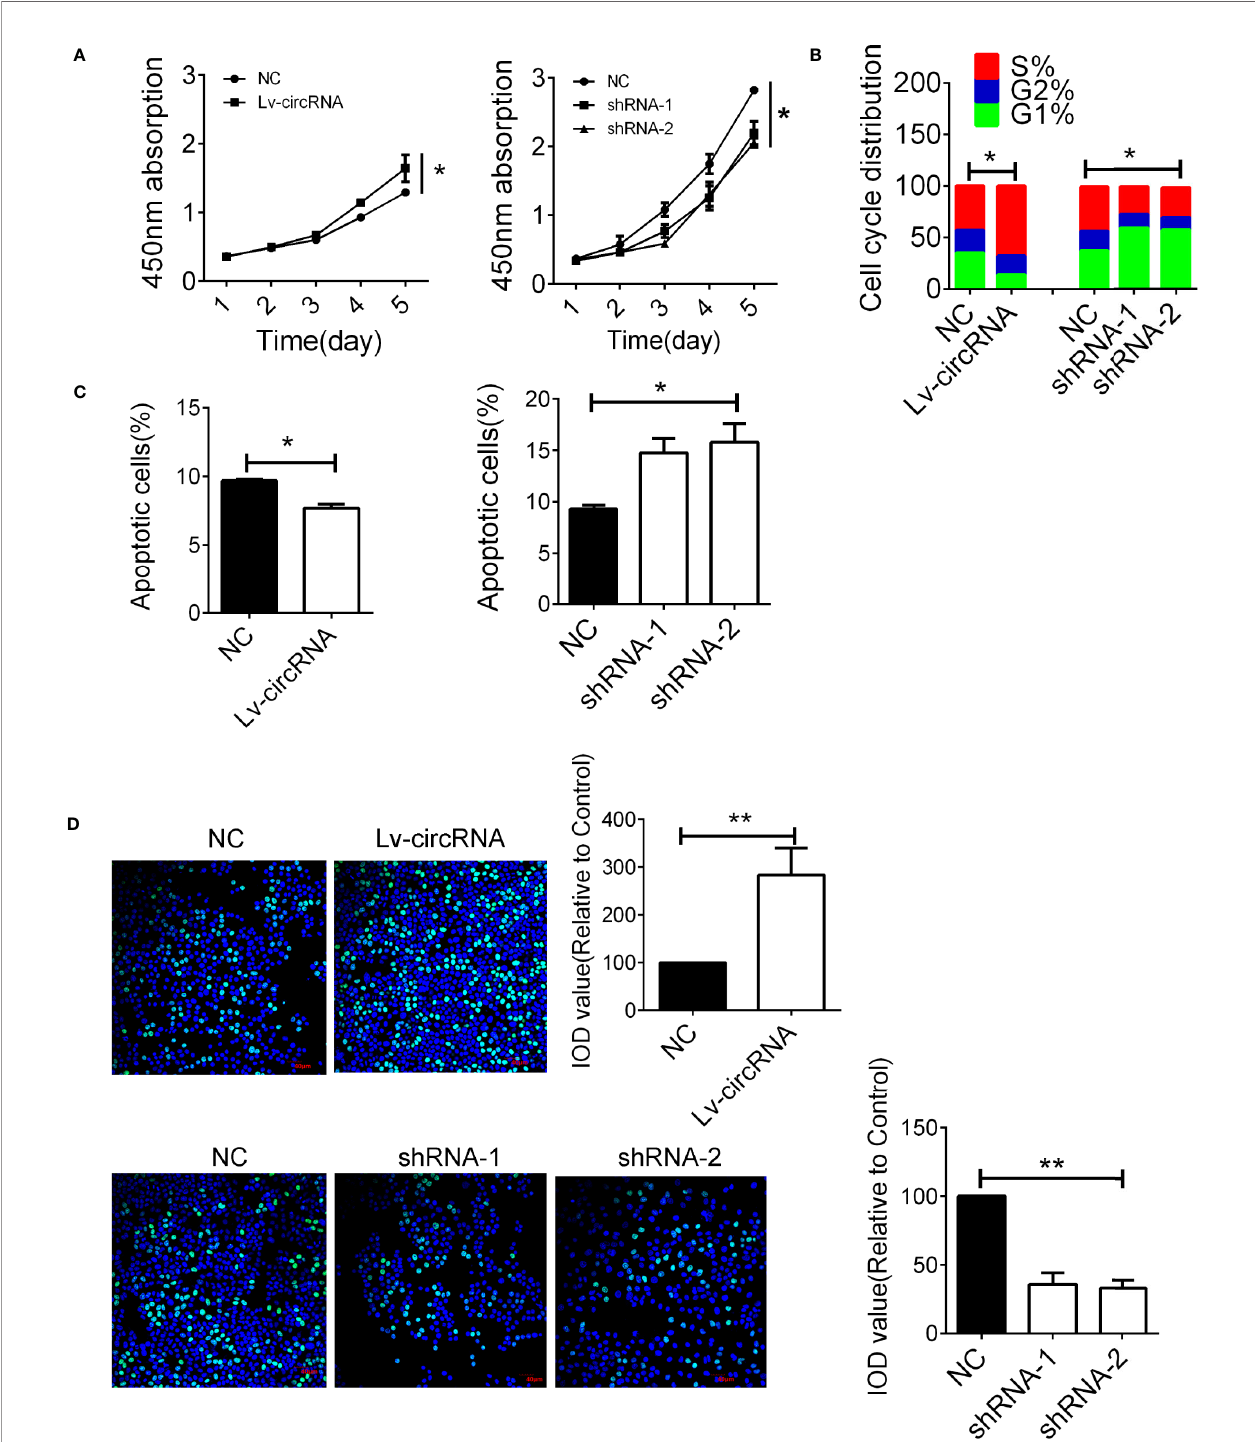
FIGURE 2 | The circ_0032822 promoted cell function of HNSCC (A) CCK8 assay in cells treated with circ_0032822 overexpression or knocking-down lentivirus. The F value for the ANOVA analysis between shRNAs and control group was 10.2. (B) Cell cycle distribution in cells. The F value for the ANOVA analysis between shRNAs and control group was 12.1. (C) Cell apoptosis detected by fl ow cytometry. The F value for the ANOVA analysis between shRNAs and control group was 14.6. (D) EDU assay in HNSCC cells. The F value for the ANOVA analysis between shRNAs and control group was 28.1. * indicated P < 0.05, ** indicated P <